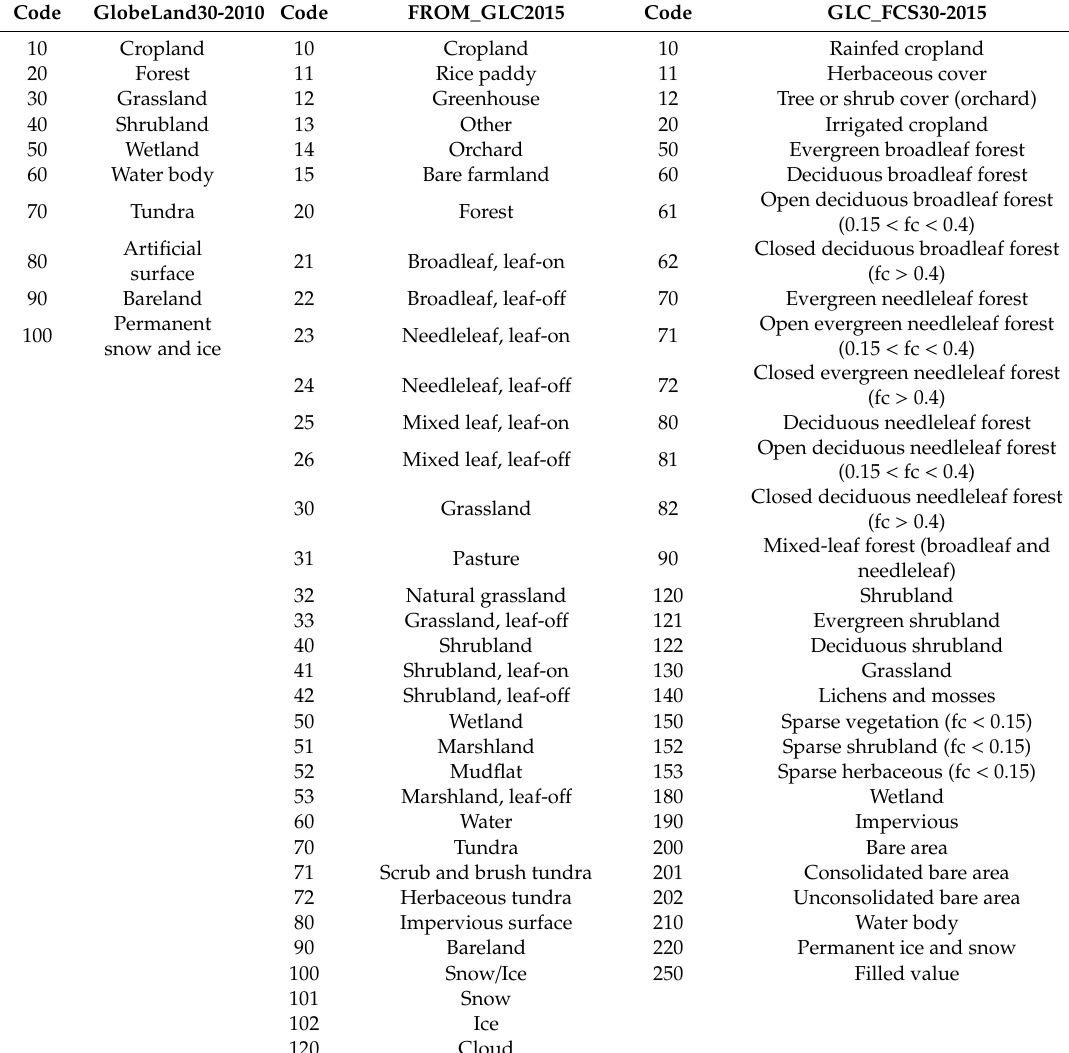
Table 2. Original classification systems and codes for di ff erent land cover products.